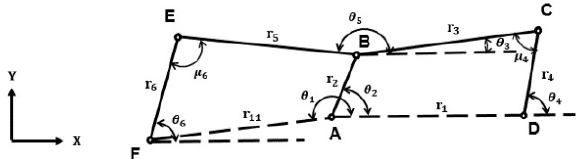
Figure 5. Simplified planar model of the CDLS.